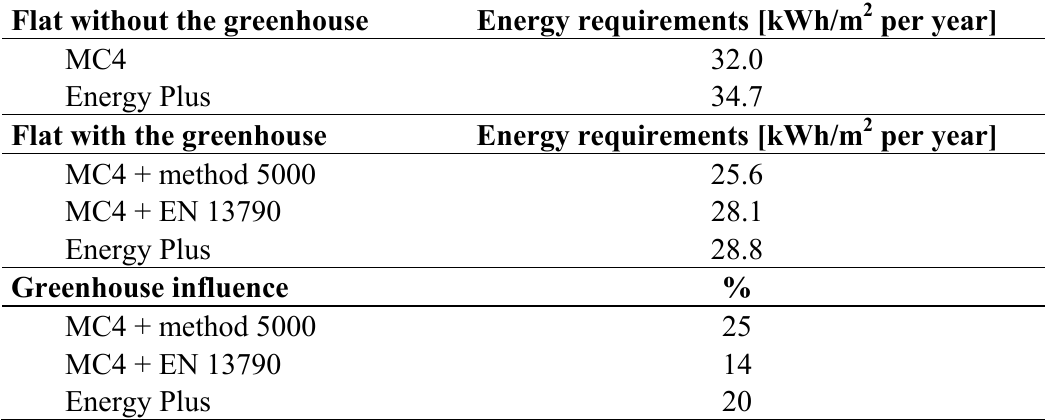
Table 6. Greenhouse energy contribution: simulation results (envelope dispersions).